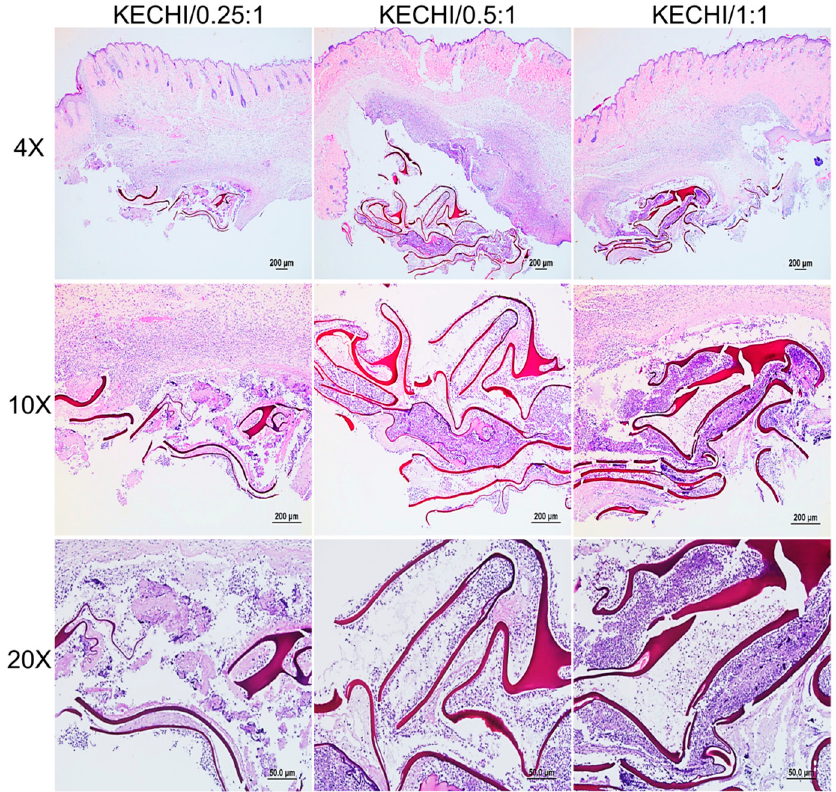
Figure 9. Histological sections of keratin-chitosan membranes subcutaneously implanted after one week.